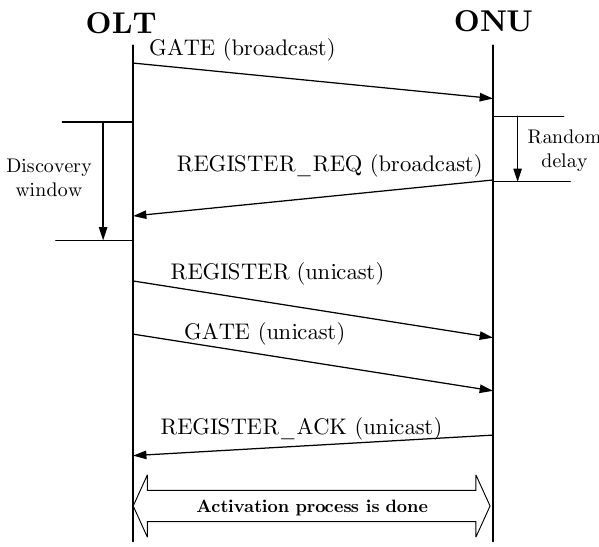
Figure 3. Activation process in EPON